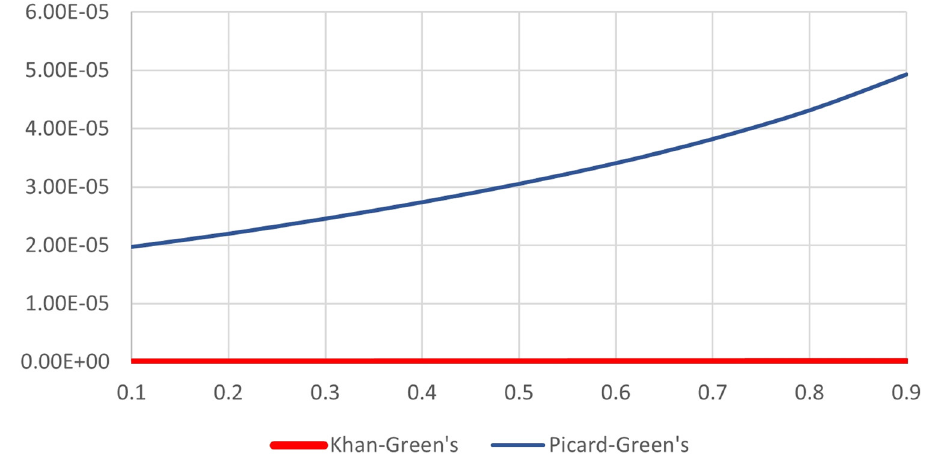
Figure 1: The relative absolute errors of Example